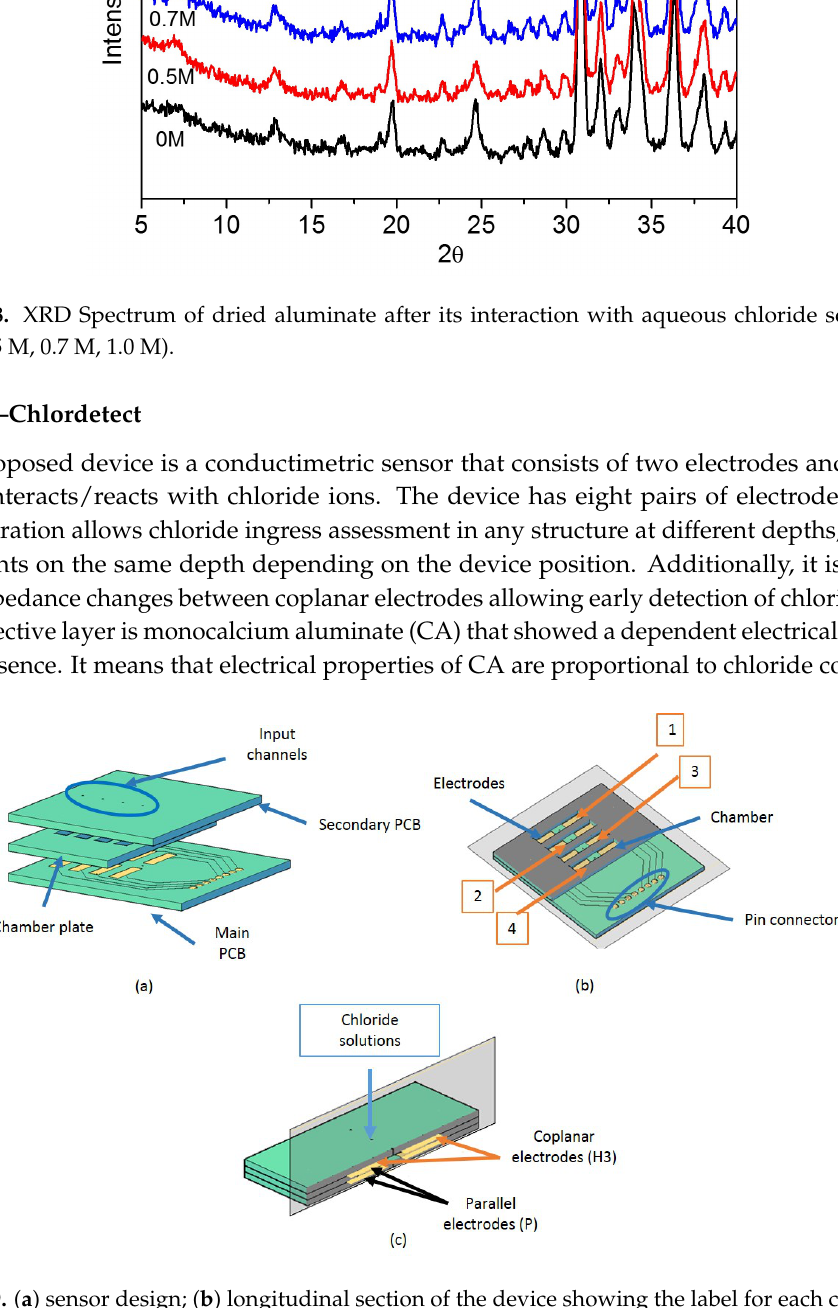
Figure 9. ( a ) sensor design; ( b ) longitudinal section of the device showing the label for each chamber; and ( c ) cross section of the third chamber showing the label of each capacitor according to the